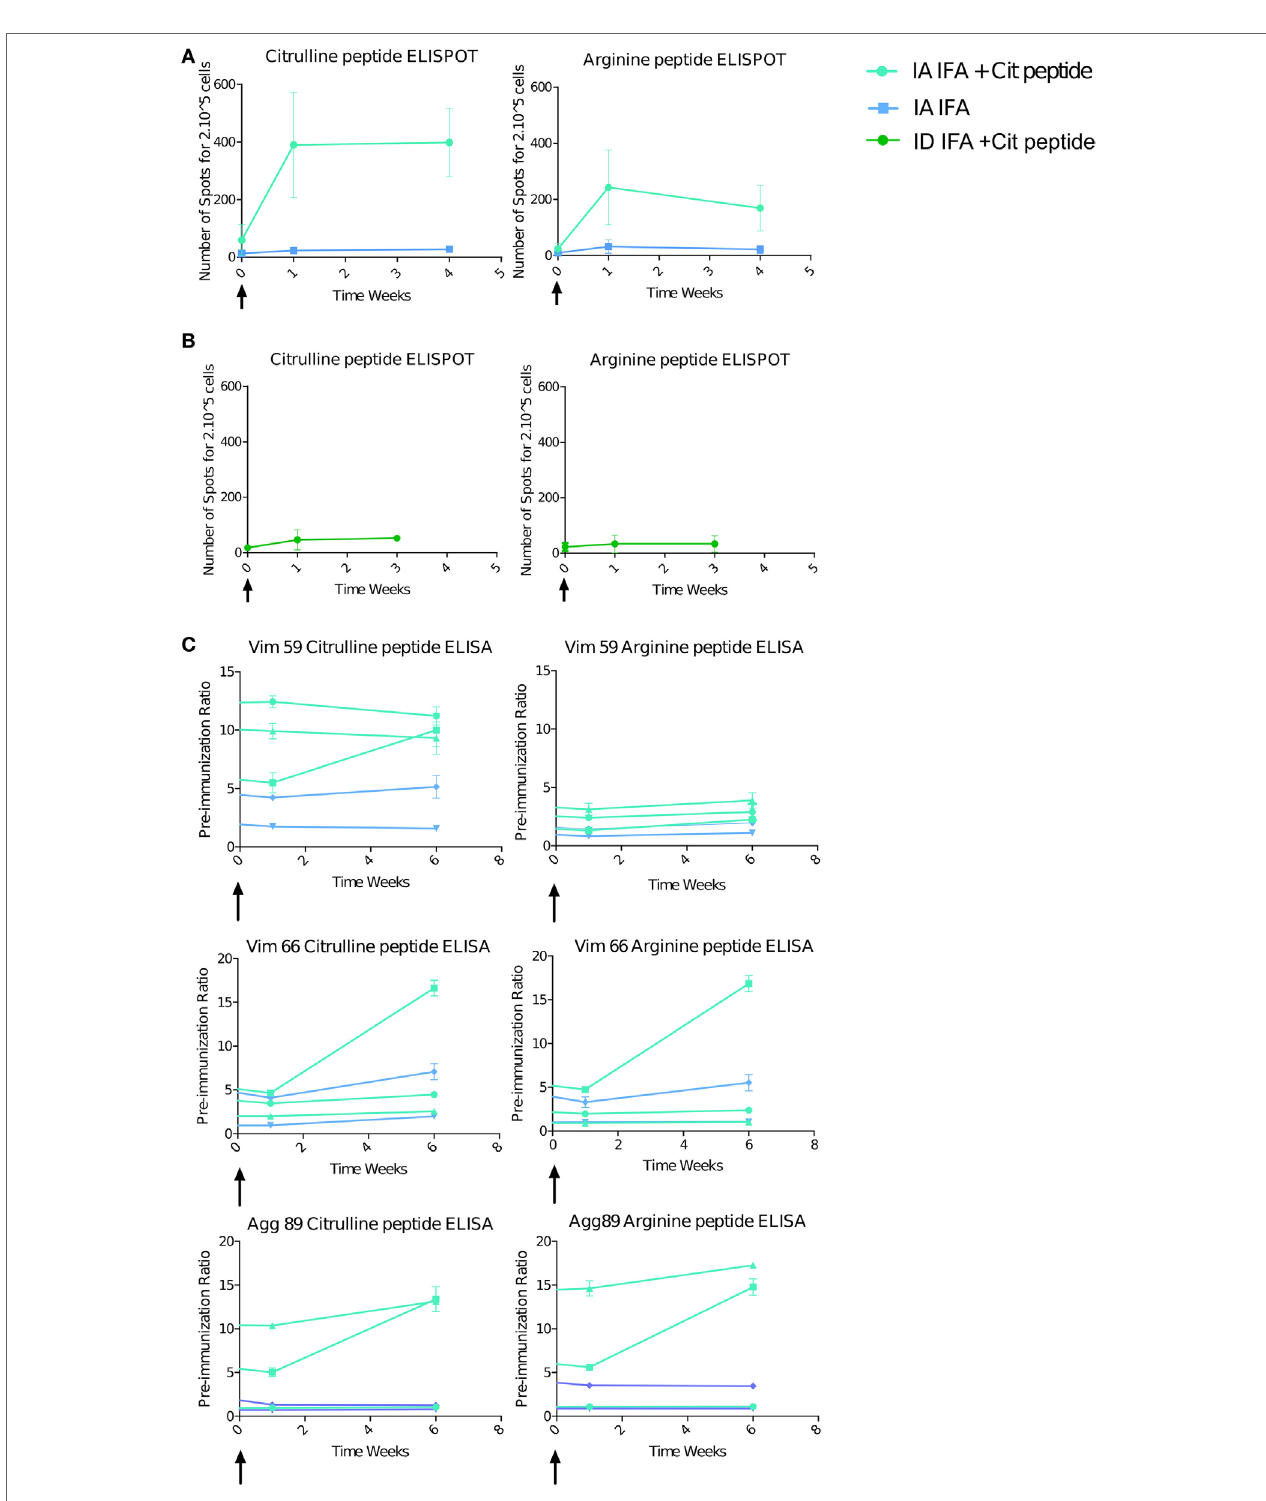
FigUre 4 | Intra-articular (IA) boost with citrullinated peptides and incomplete Freund’s adjuvant (IFA) induces a strong immune response. At 30 weeks’ post-initial prime, animals received an IA boost with pooled citrullinated Vim59 and 66, Fg79, and Agg89 plus IFA ( n = 3) or IFA alone ( n = 2). (a) T-cell response assessed by interferon-gamma (IFN γ ) Enzyme Linked Immunospot (ELISPOT) against the pooled citrullinated or arginine pool of peptide. Data are mean ± SD values for individual animals (performed in triplicate). (B) At 34 weeks’ postimmunization, two animals were intradermally boosted with the same citrullinated peptide pool, and response was assessed by IFN γ ELISPOT. (c) ELISA of B-cell response against Vim59 and 66, Fg79 and Agg89 in their citrullinated and arginine form. Data are mean ± SD values for individual animals (performed in triplicate). The time scale is shown as time post-IA